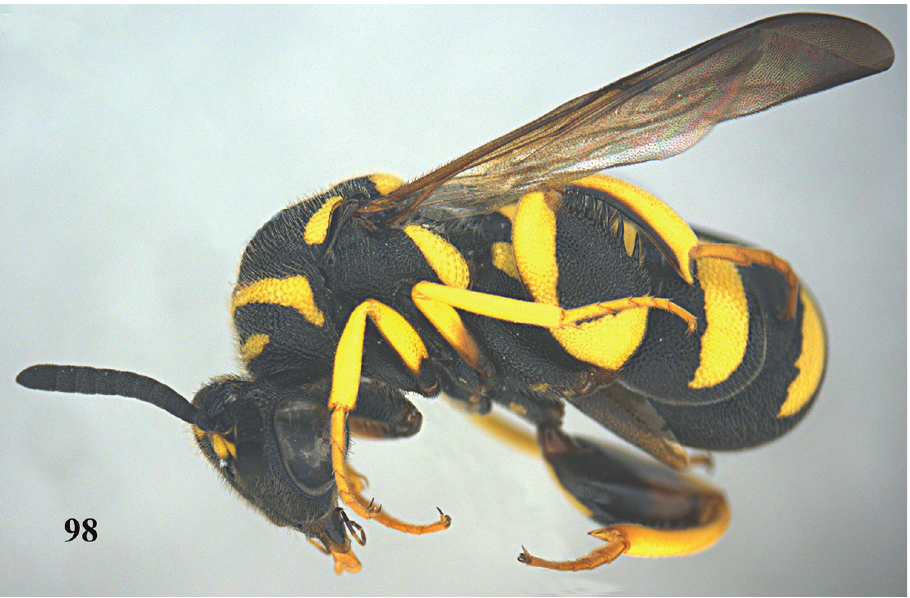
Figure 98. Leucospis intermedia Illiger, ♀ from Xinjiang, Gongliu, habitus